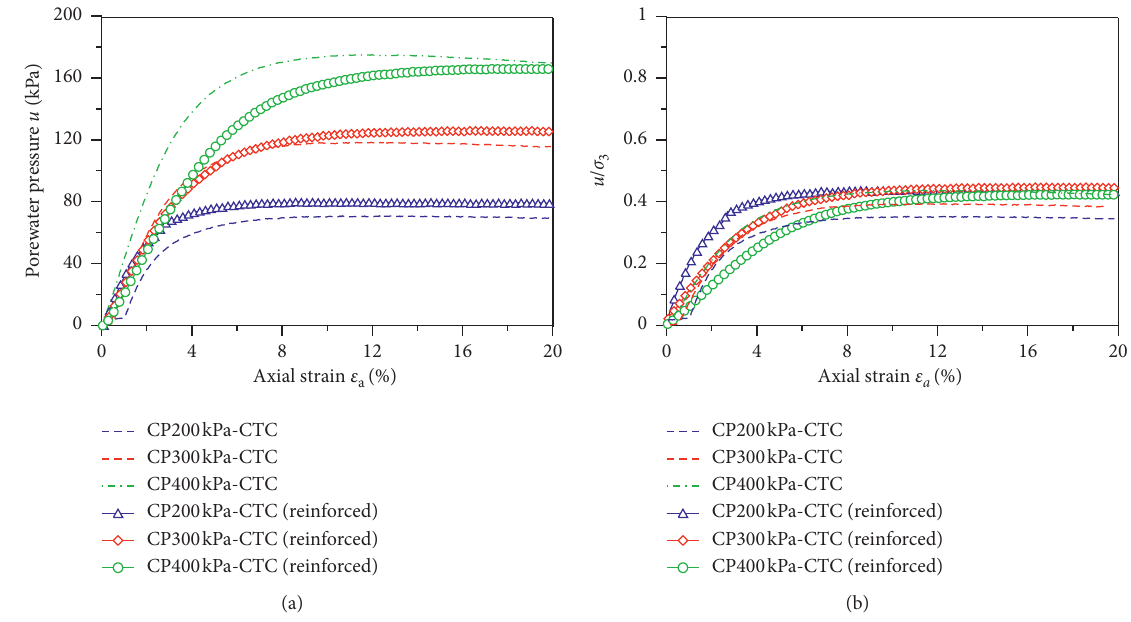
Figure 4: Pore pressure response of Lantian loess and reinforced Lantian loess under the CTC stress path: (a) pore pressure u versus axial strain ε a and (b) u / σ 3 versus axial strain ε a .